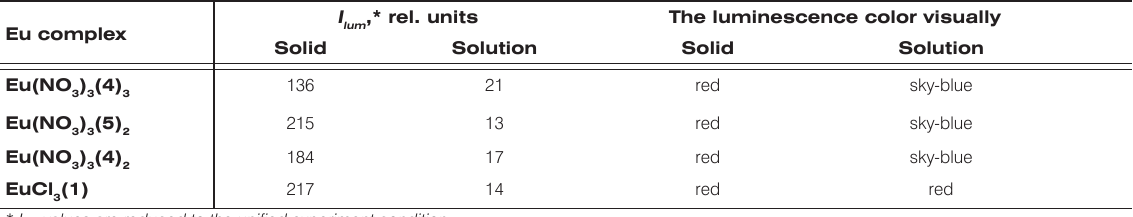
) of the europium complexes in the solid state and in solution in the abs. EtOH (c= 1×10 -3 М ). lum I ,* rel. units The luminescence color visually lum